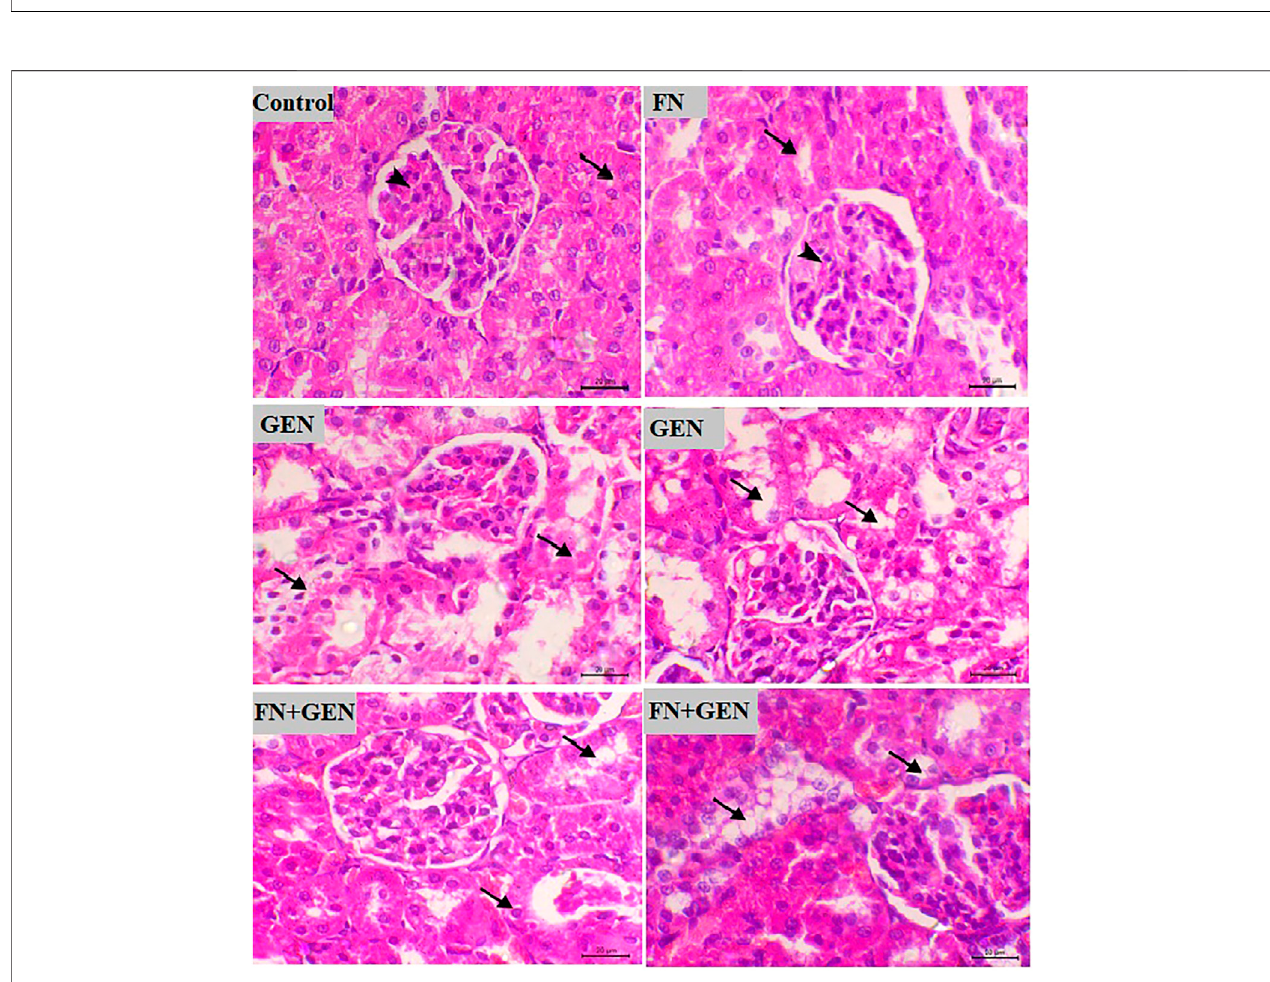
FIGURE 2 | FN prevents renal destruction in GEN-administered animals. Photomicrographs of renal sections from control rats and FN-treated rats demonstrating normal histology of the glomeruli and tubules (arrowhead and arrow, respectively), GEN-treated animals demonstrating congestion of the glomerular tuft and vacuolar degeneration in the renal tubules (arrows), and GEN-administered rats pre-treated with FN showing a noticeable decrease in the vacuolar degeneration in the tubular epithelia (arrows) (H&E, X400, scale bar = 20 µm). FN: formononetin; GEN: gentamicin; and H&E: hematoxylin and eosin.